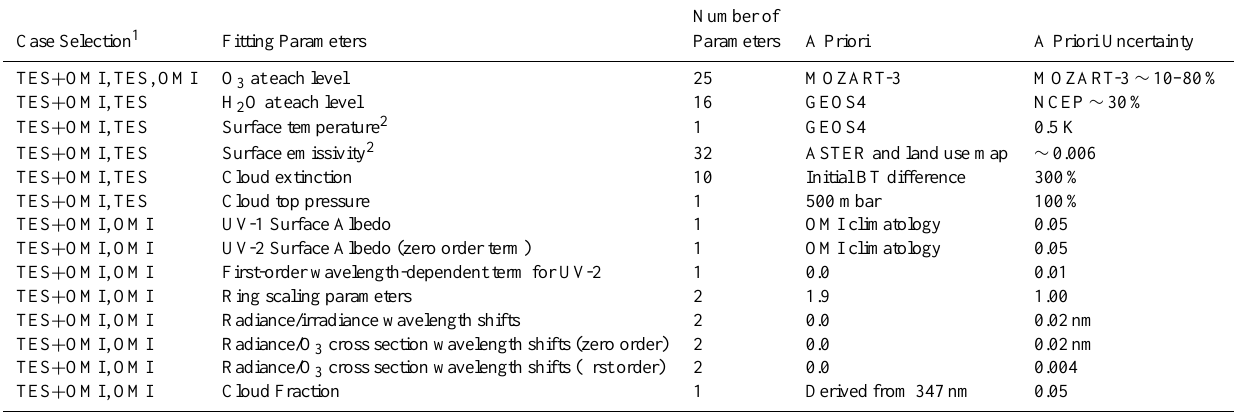
Table 3. List of fitting variables, a priori values and a priori